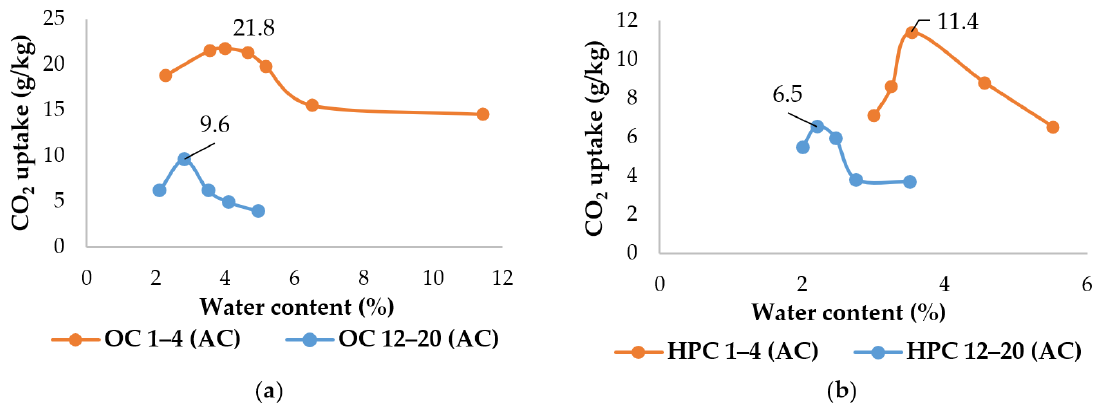
Figure 9. Effect of the RCA size on the CO 2 uptake ( a ) for OC and ( b ) for HPC (one accelerated carbonation test for these RCAs at these water